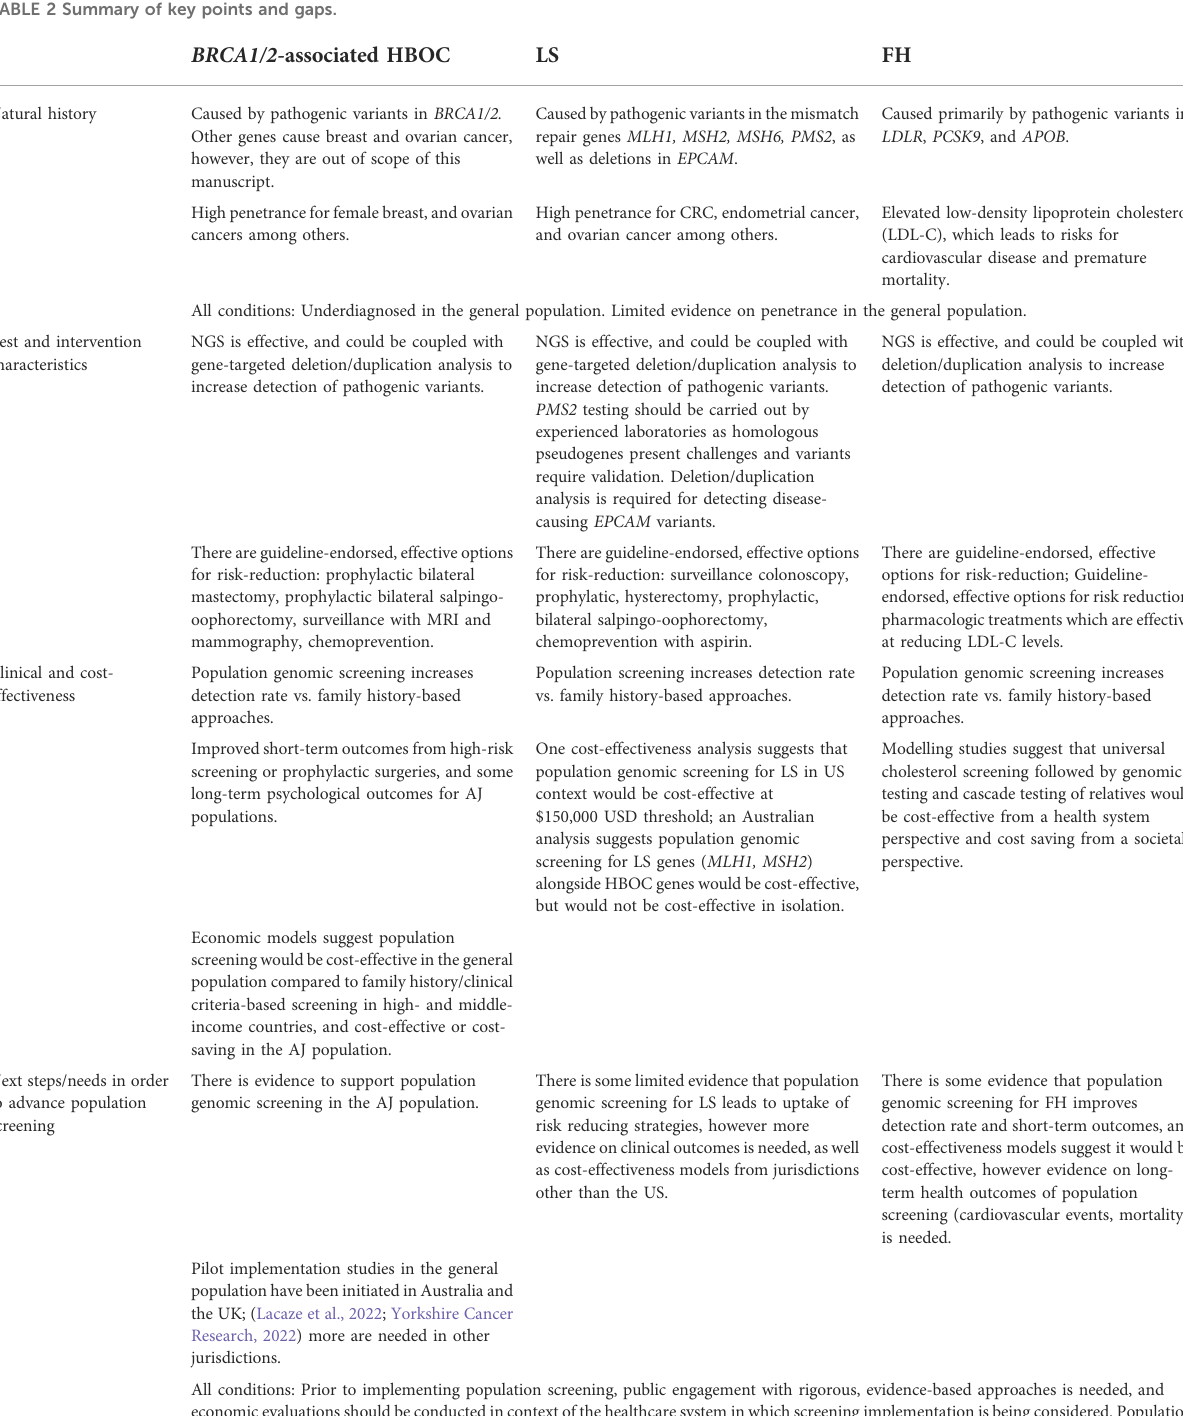
TABLE 2 Summary of key points and gaps. BRCA1/2 -associated HBOC LS